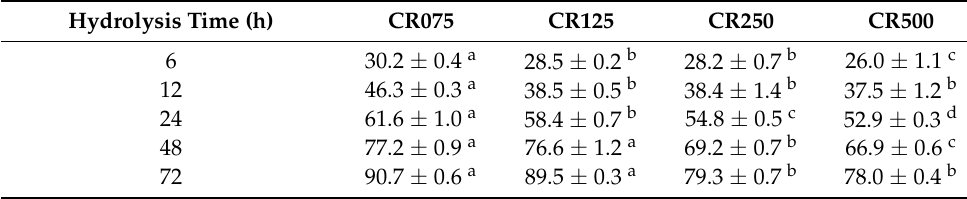
Table 3. Hydrolysis yield (%) of different cassava